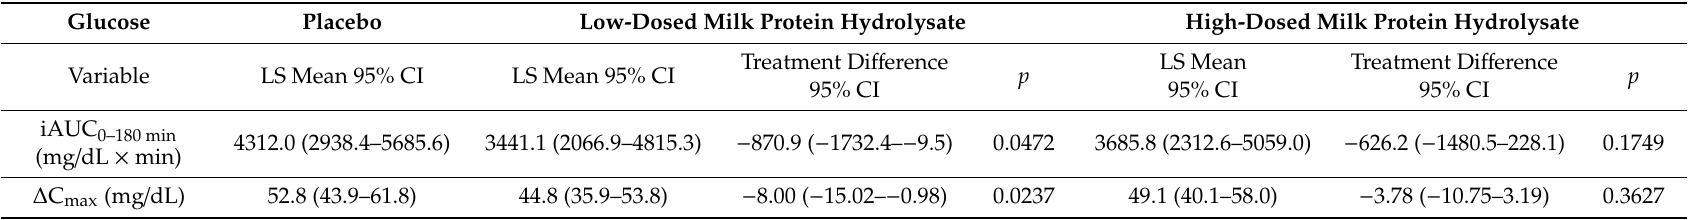
Table 2. Postprandial glucose incremental areas under the curve (iAUC) and ∆ C max of glucose after single dose intake of placebo or low-or high-dosed milk protein hydrolysate. Group means referred to least squares (LS)